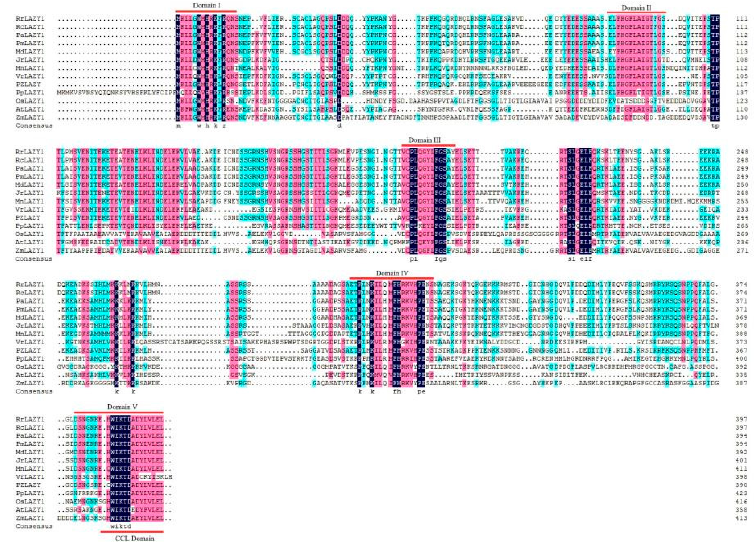
Figure 1. Amino acid sequence homology analysis of RrLAZY1 and LAZY1 genes from other species. Five conserved domains of the LAZY1 gene were presumed to be represented by red lines. The conserved domain II contains the G Φ L (A/T) IGT domain. The C-terminus of region Ⅴ has a highly conserved CCL domain and contains the EAR motif (L/FVLEL).